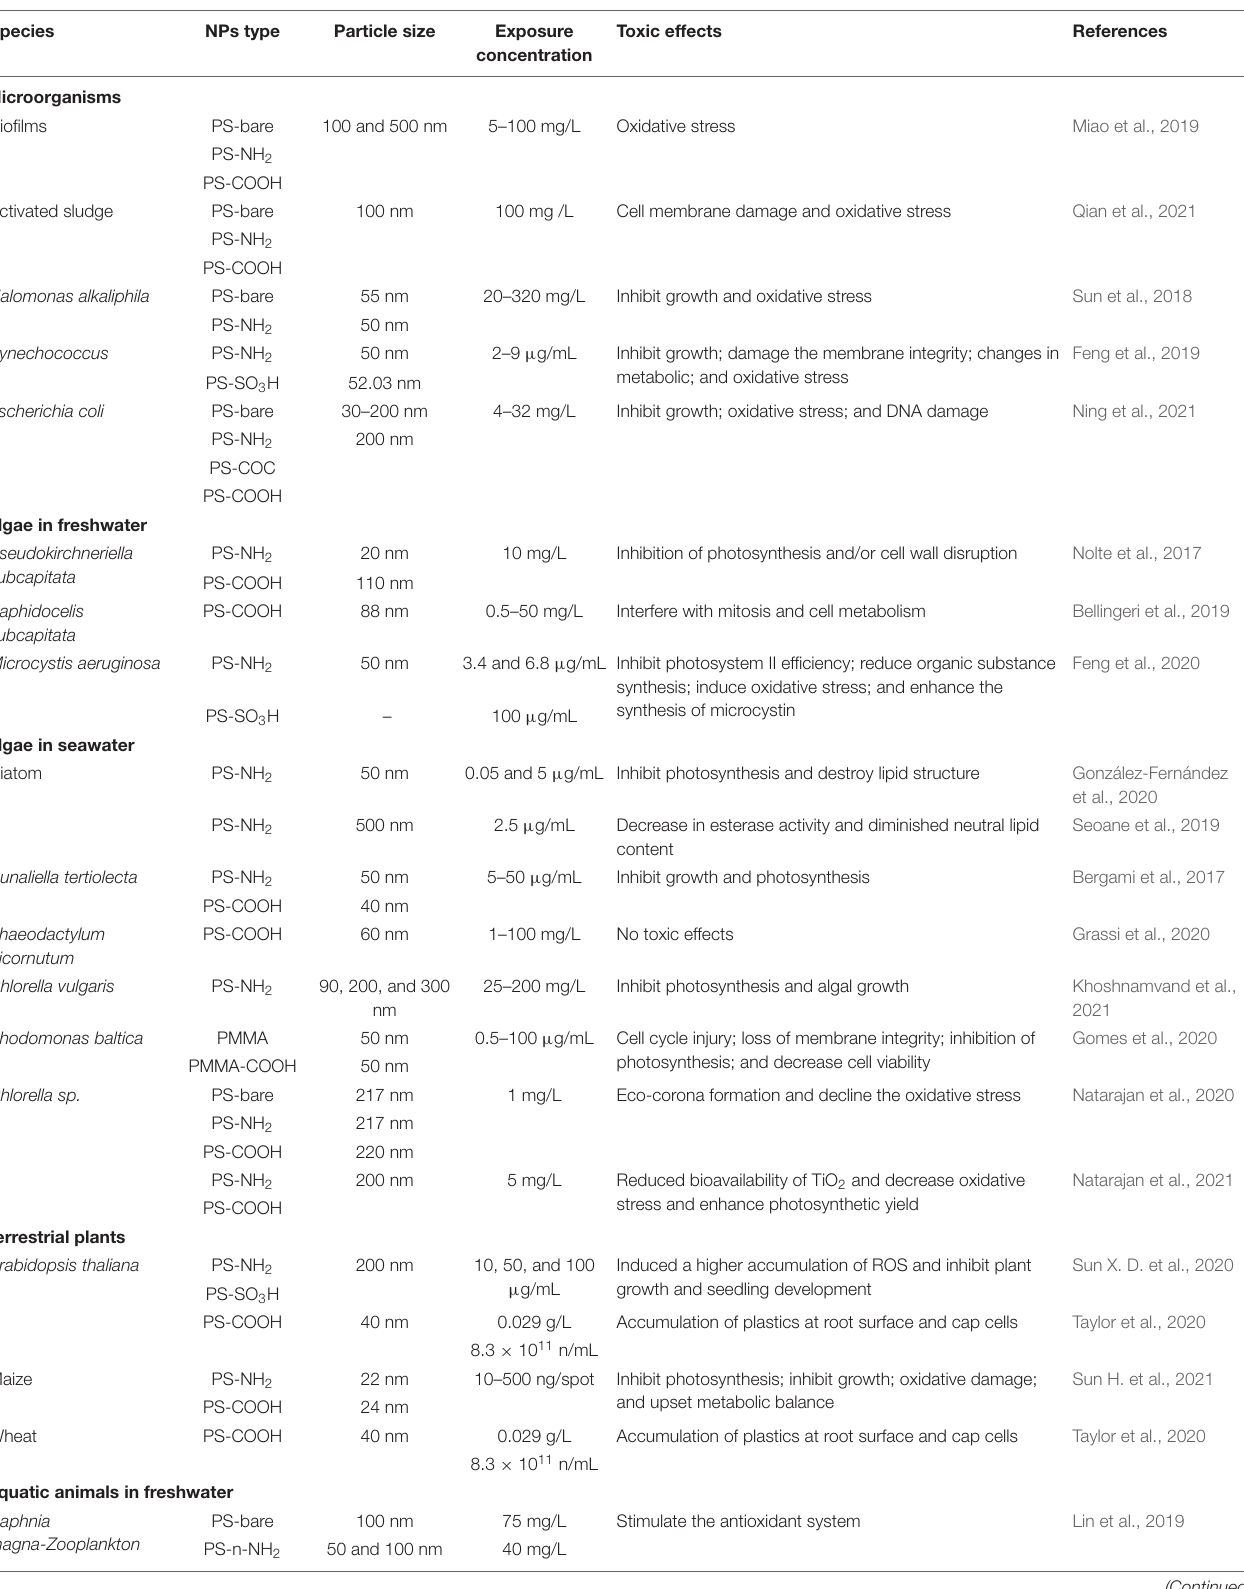
TABLE 1 | Summary of toxicity assessment of NPs with different functional